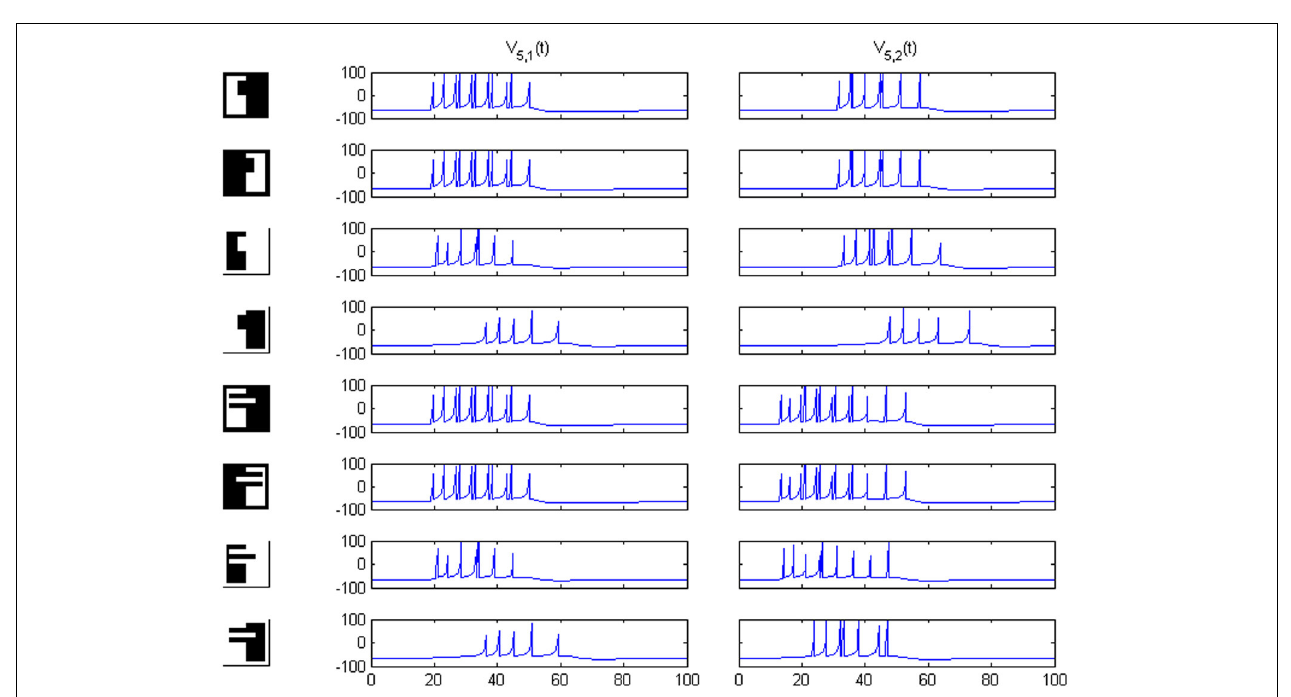
same. The two originals have inner size n = 64 without margins, outer size N = 76 including margins, and an equal area ratio of 0.42 without frame, 0.30 including frame.